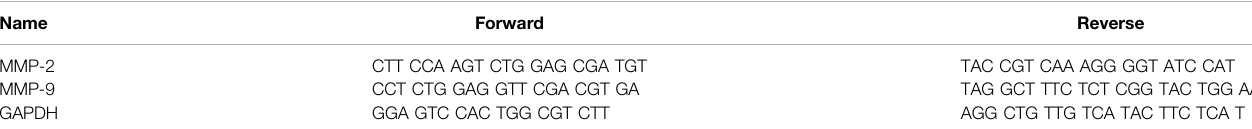
TABLE 1 | Sequences of the primers. Name